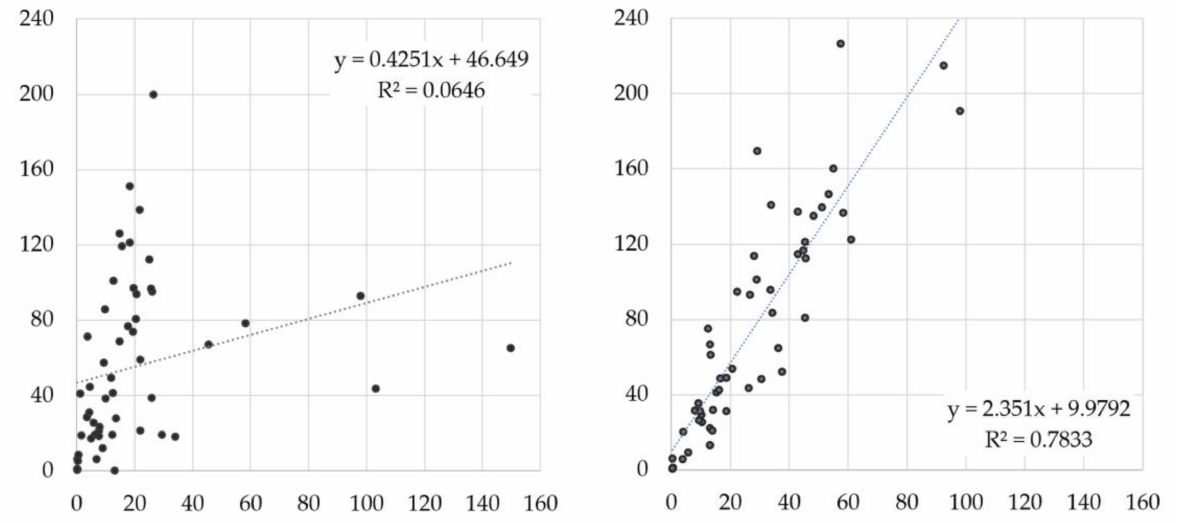
Figure 2. Linear regression analysis for the variables “SOC stock in surface horizons” and “SOC stock in complete soil profile” ( left ); “SOC stock for a supposed 30 cm sampling” and “SOC stock in complete soil profile” ( right ).